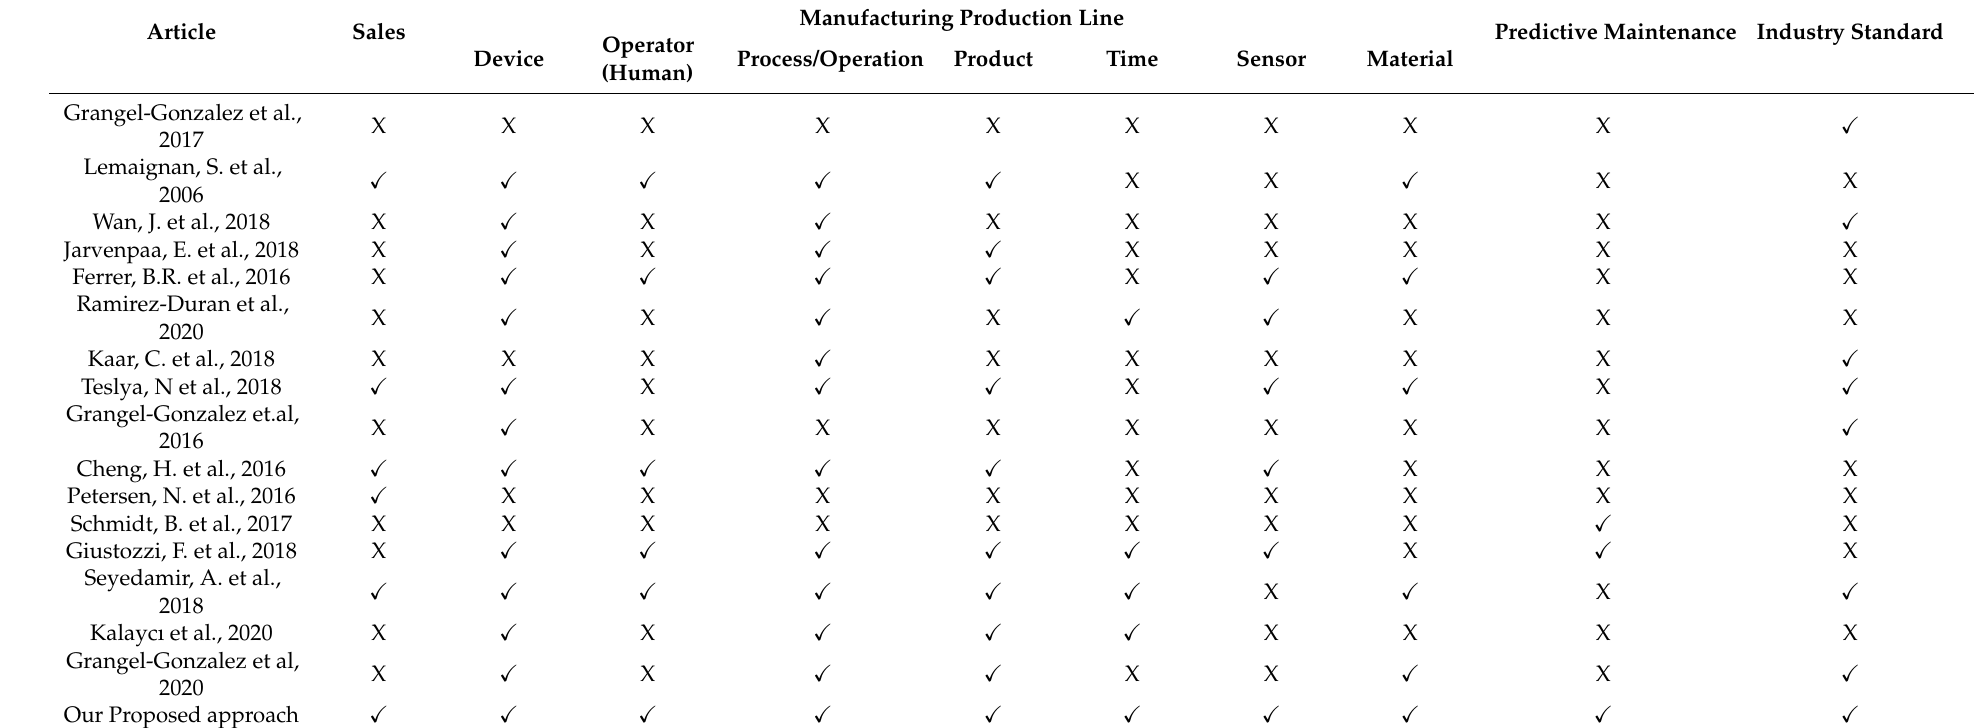
Table 4. Manufacturing production line concepts covered by different research